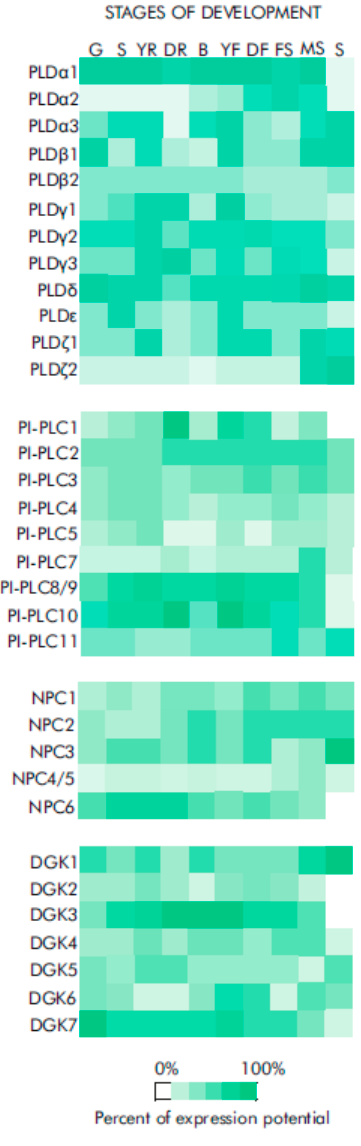
Figure 2. Expression levels of genes encoding enzymes of PA signaling at different developmental stages of Arabidopsis thaliana obtained using “Genevestigator” database [55]. Data were collected